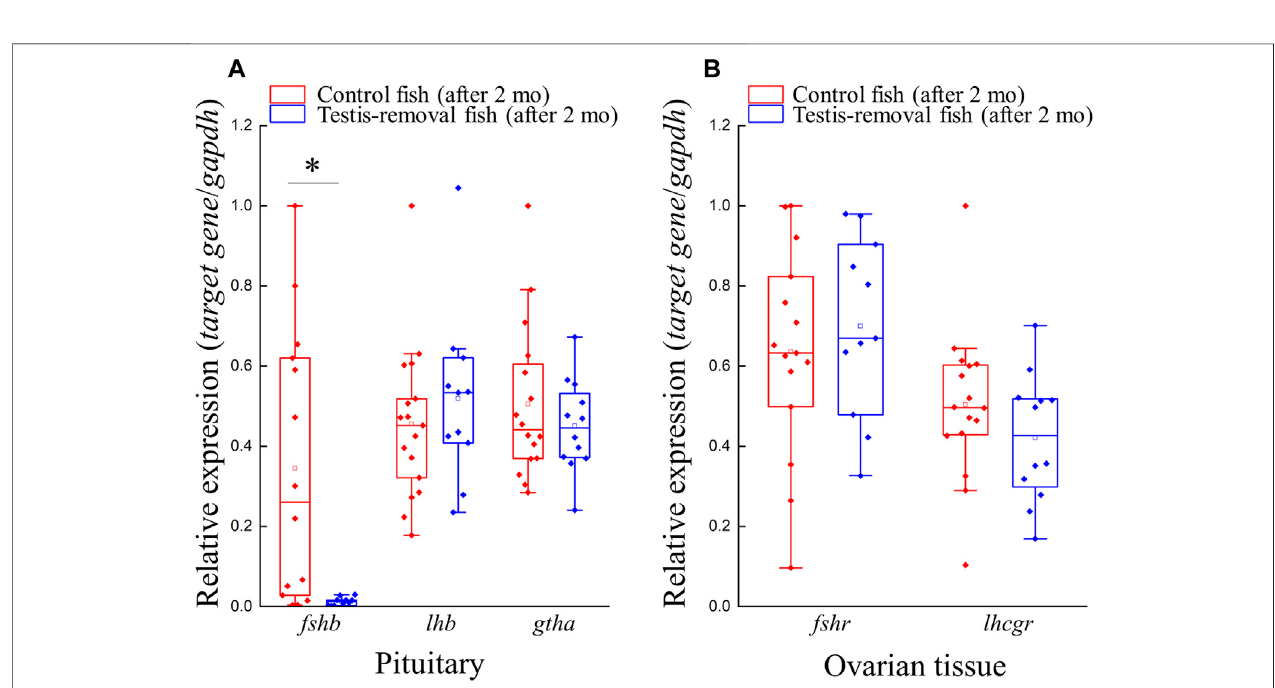
FIGURE3| Genesexpressionpro fi lesofgths( fshb , lhb ,and gtha )and gthrs ( fshr and lhcgr )aftertestis-removalinducedfemaleness.Therewasnodifferenceincell composition of ovarian tissue in the control fi sh and testis-removed fi sh at 2 months after surgery. To understand the change of gths and gthrs in secondary sex determination, qPCR analysis for pituitary and ovarian tissue was used, respectively. Relative expression was normalized with gapdh , and the highest sample value of each gene in the control fi sh was de fi ned as 1. Asterisks indicate signi fi cant differences by Student ’ s t -test (*, p < 0.05).